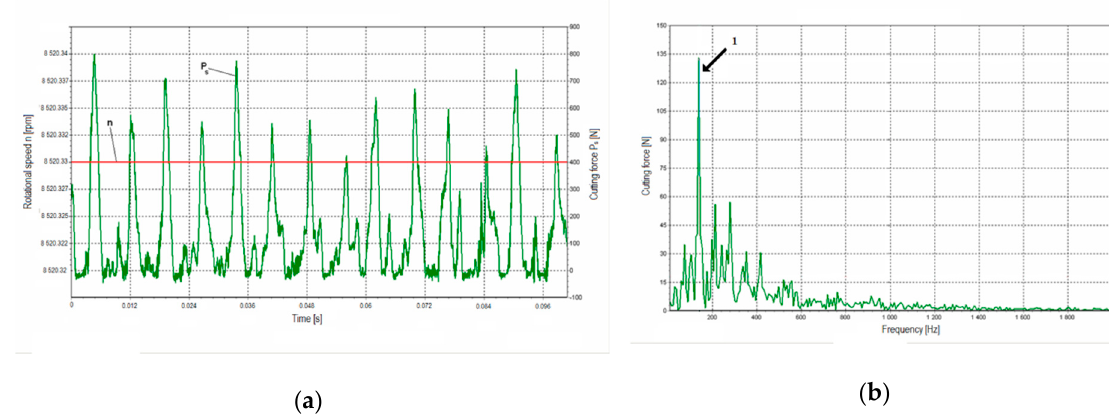
Figure 7. Cutting force variability at a feed force of 89 N ( a ) and the frequency structure of the cutting